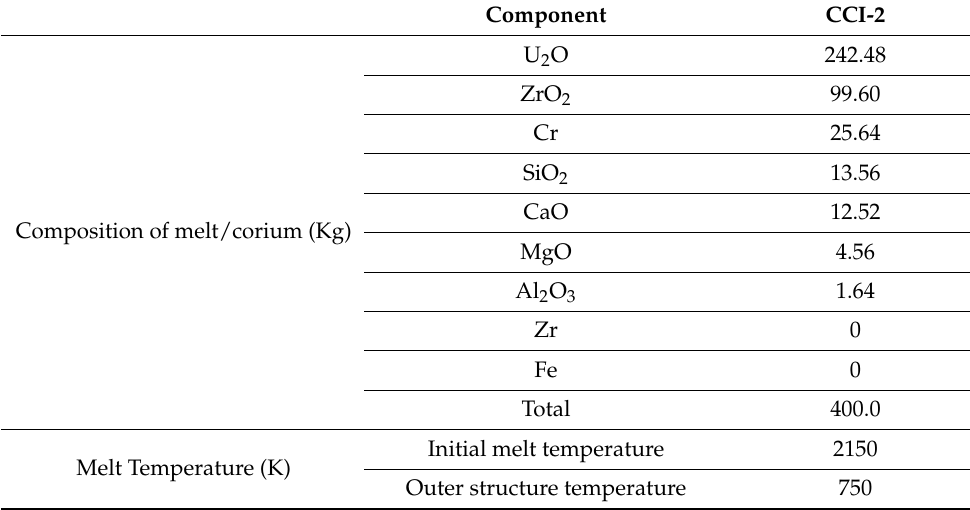
Table 3. Melt/corium composition and its thermal properties for